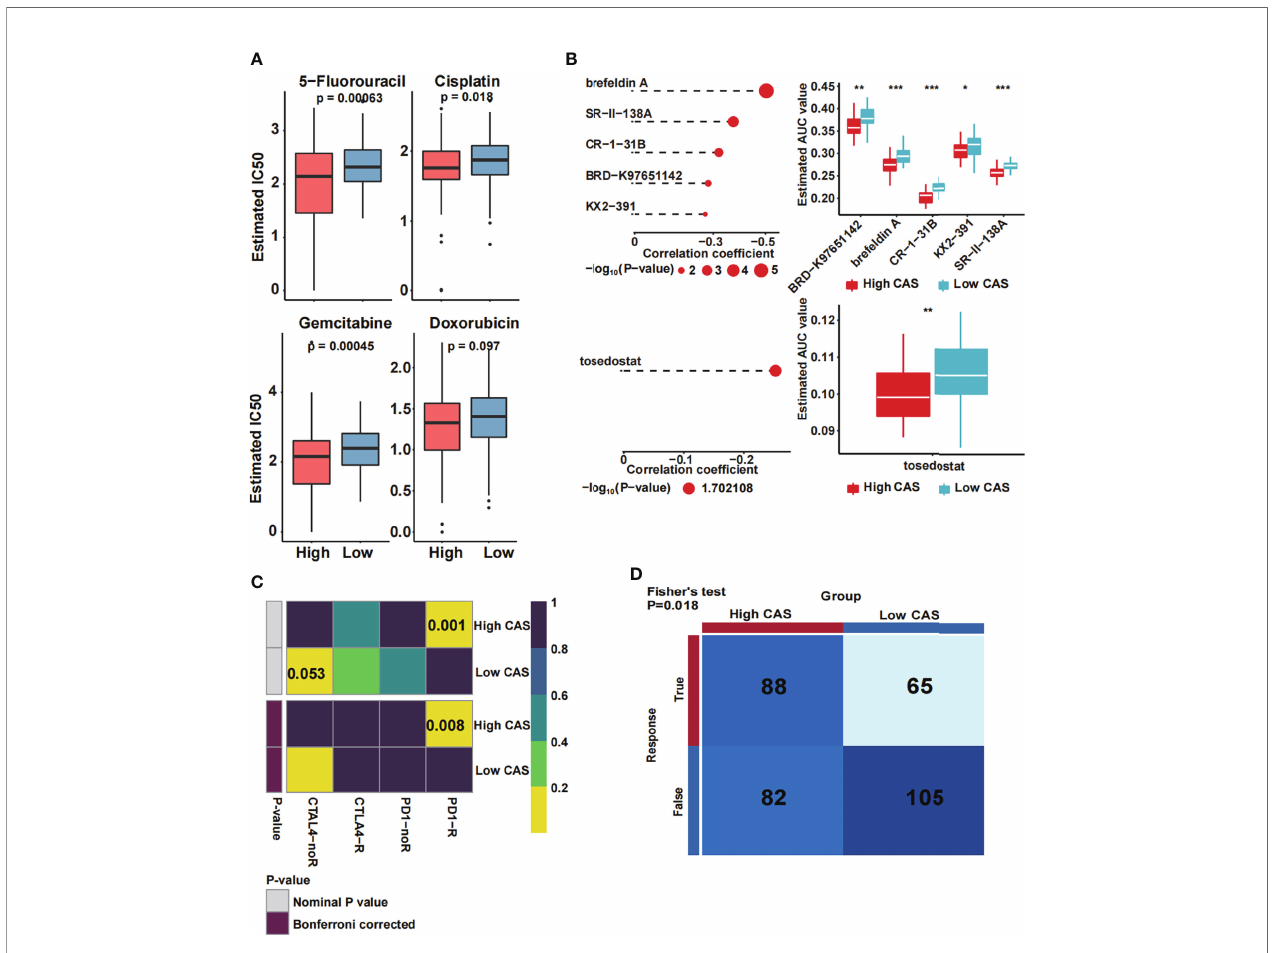
FIGURE 8 | Prediction of drug and immune response. (A) The estimated IC50 of four common chemotherapeutic drugs in high- and low-CAS samples. (B) The prediction and the estimated AUC value of small-molecule drugs in the CTRP 2.0 and PRISM databases. (C) The immune response against PD1 and CTLA4 in patients with high and low CAS. (D) The total immune response in patients with high and low CAS. *P-value < 0.05; **P-value < 0.01; ***P-value <